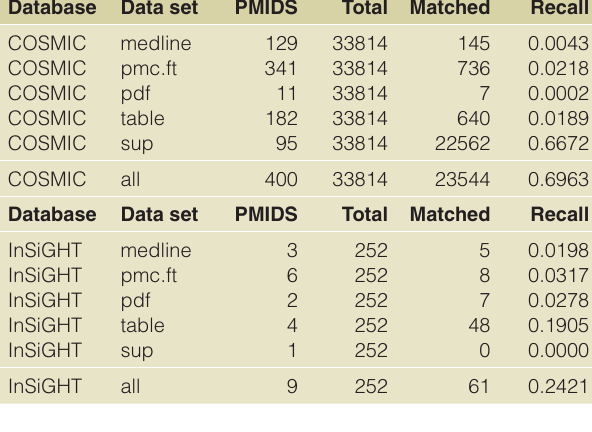
(pdf), tables available from the Open Access PMC Articles’ XML (table), supplementary material (sup) and the combination from all the sources